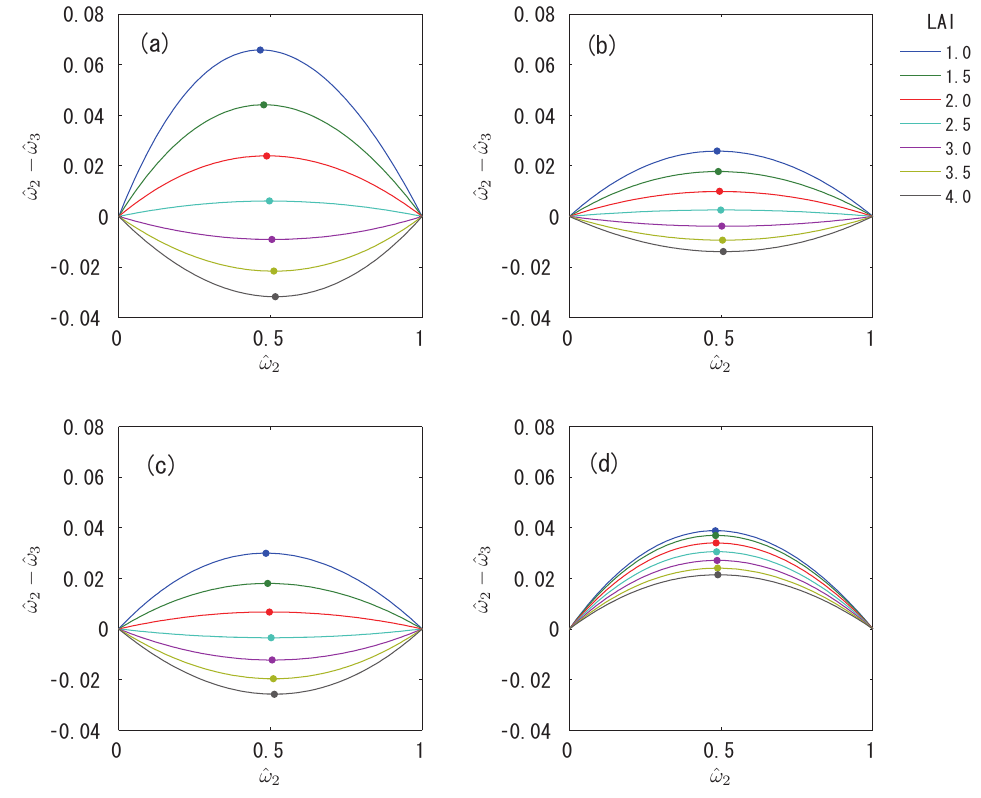
− ^ ω Figure 6 . Plot of ( ^ ω ) against ^ ω under various vegetation endmember spectra for the 3 2 2 case of four VIs ((a) NDVI, (b) SAVI, (c) TSAVI, and (d) EVI2). The endmember spectrum = (0 . 15 , 0 . 22) . The maximum difference for each case of non-vegetation class is fixed at ρρρ s is indicated by a dot (computed from Equations (46) and